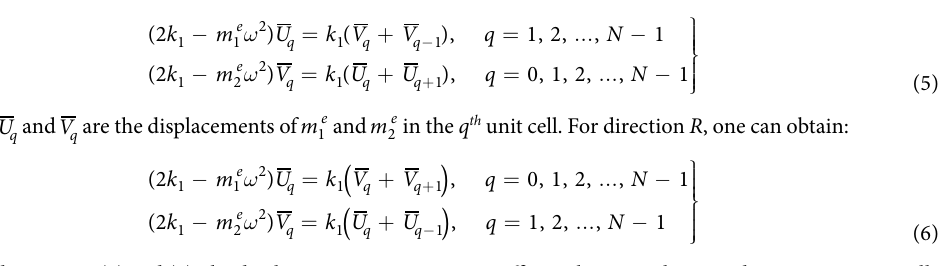
According to Eqs (5) and (6), the displacement transmission coefficient between the two adjacent inner unit cells L and T R , can be written respectively for directions L and R , T q q